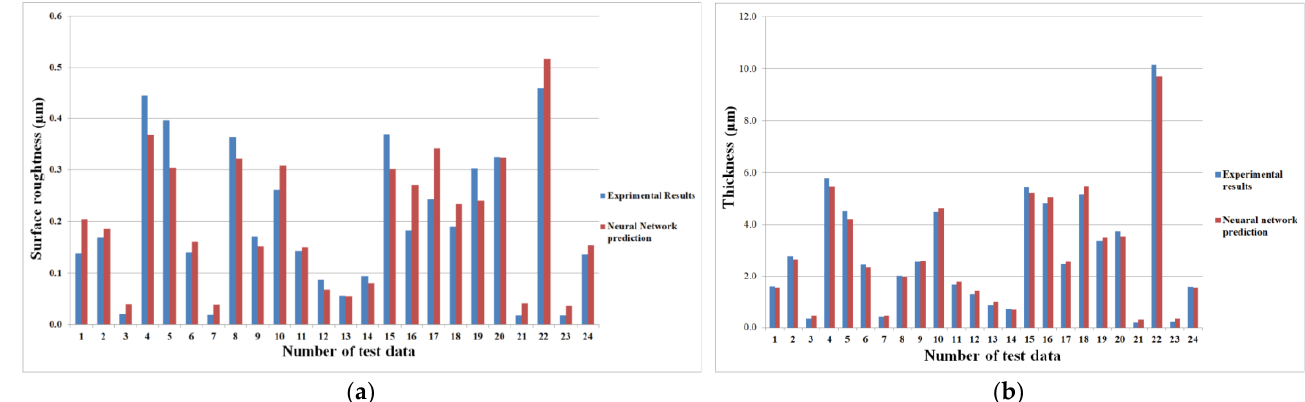
Figure 6. Verification of ANN results with experimental results: ( a ) surface roughness comparison with the experimental result; ( b ) layer thickness comparison with the experimental result.